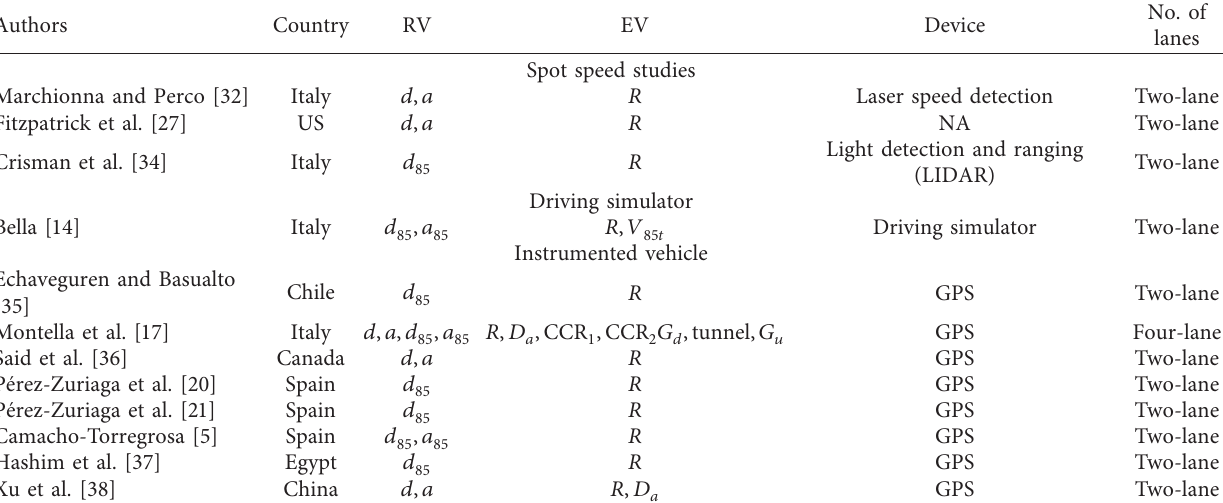
Table 3: Summary of the existing literature for acceleration and deceleration rate